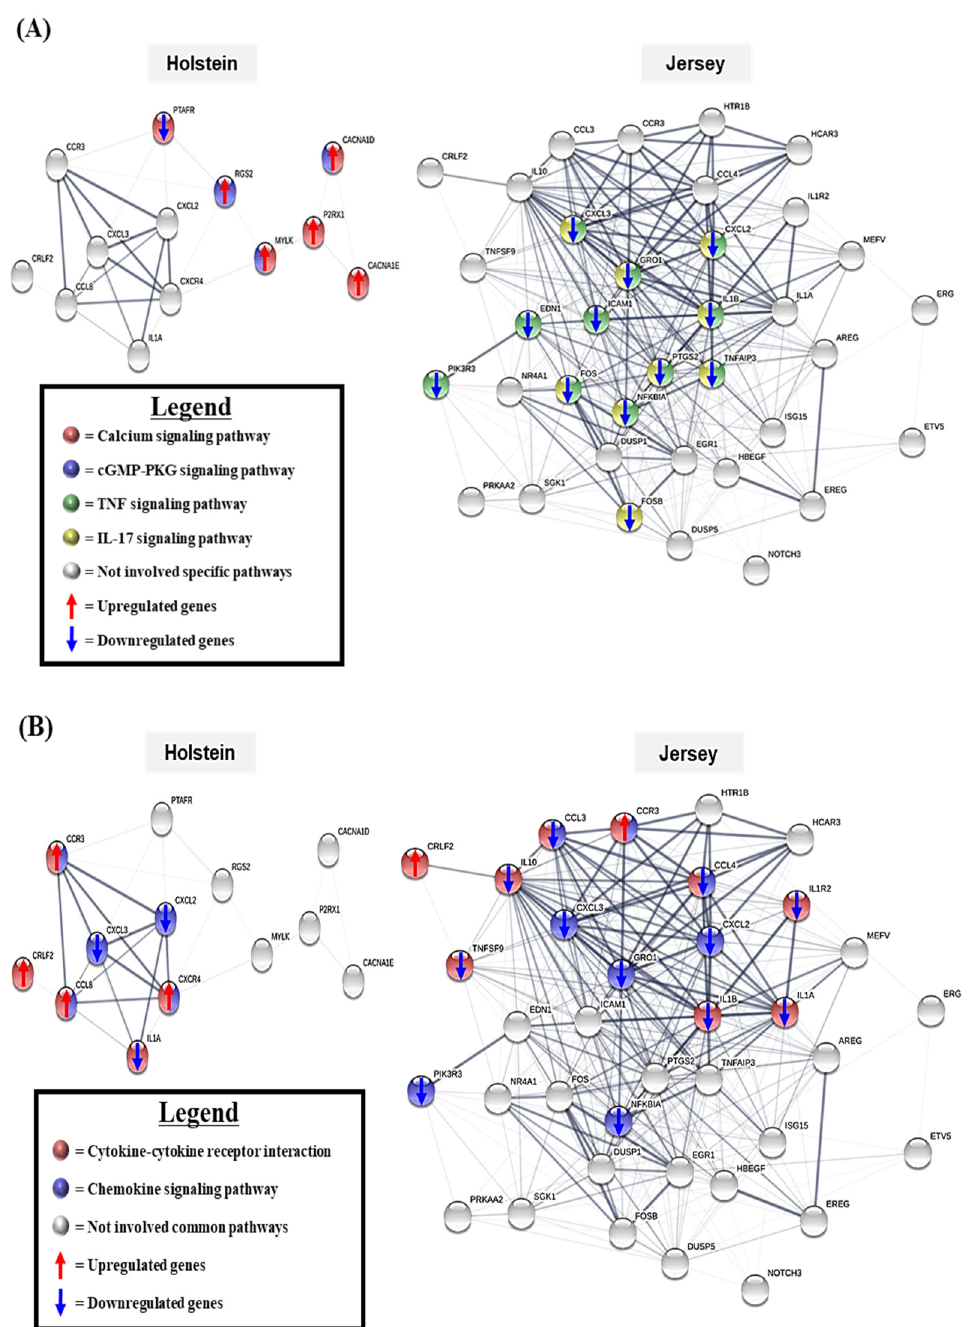
Figure 5. Gene network analysis of differentially expressed genes in predominant pathways. Gene network analysis was performed with the top five significant KEGG pathway-related DEGs of each dairy cow breed. The breed-specific pathway gene networks ( A ) and common pathway-related gene networks ( B ). The red-up and blue-down arrows indicate the up-regulation and down-regulation of specific genes by heat stress. The line thickness indicates the strength of edge